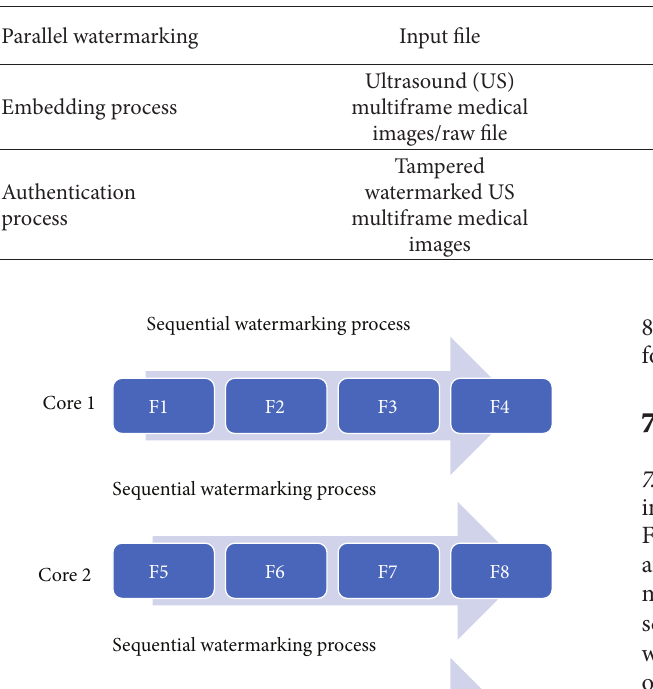
Table 3: The relationship between parallel watermarking embedding and authentication process.